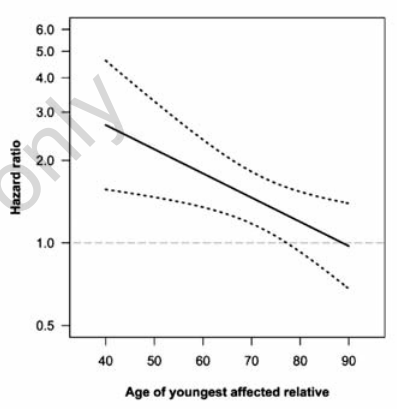
.Figure 1. The figure displays the risk of developing atrial fibrillation (AF) depend- ing on the age of AF onset in the youngest affected relative. The risk is highest, if the relative developed AF in the age of 40-50. With advancing age, the risk decreases. The hazard ratio for AF is plotted on the y-axis with a logarithmic scale. Dashed lines rep- resent 95% confidence intervals. Figure modified from Lubitz et al. 44 , with permis- sion